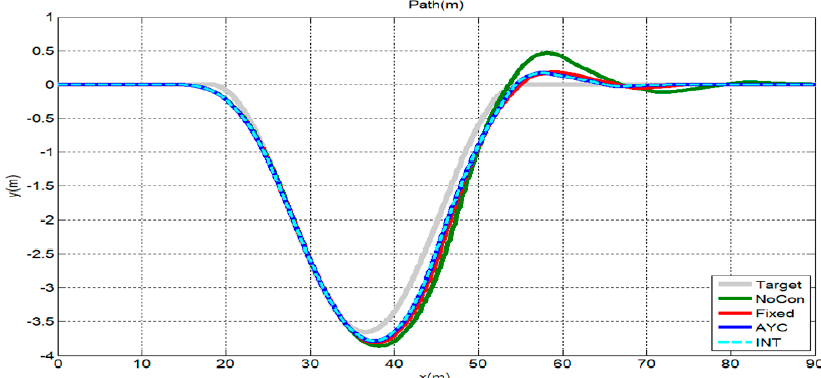
Figure 9. Target path and driving path of short double lane change (Target velocity: 50 km/h).